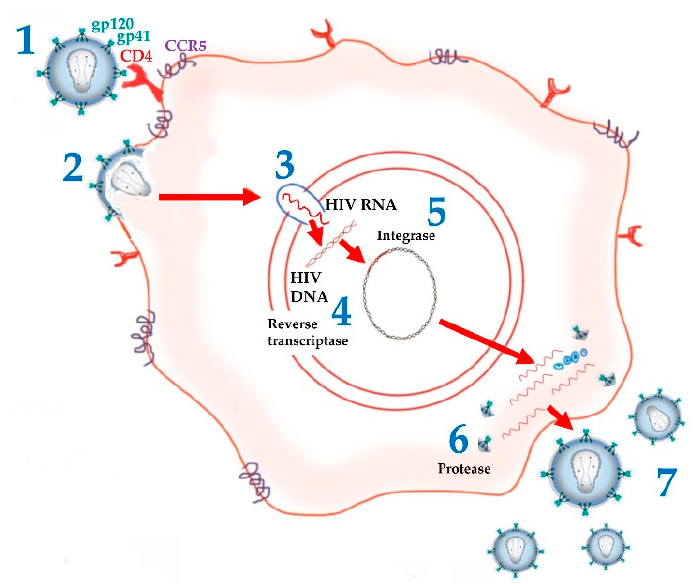
Figure 1. Stages in HIV lifecycle. (1) HIV attaches to CD4 receptor and CCR5 co-receptor. (2) HIV gp41 is exposed to the host cell and causes fusion. (3) HIV enters the nucleus and releases its enzymes and RNA. (4) Reverse transcriptase makes a double strand HIV DNA from HIV RNA. (5) Integrase includes HIV DNA in the DNA of the host cell. (6) New HIV viral components are produced, and Protease assembles new HIV virus. (7) Each host cell produces hundreds of new